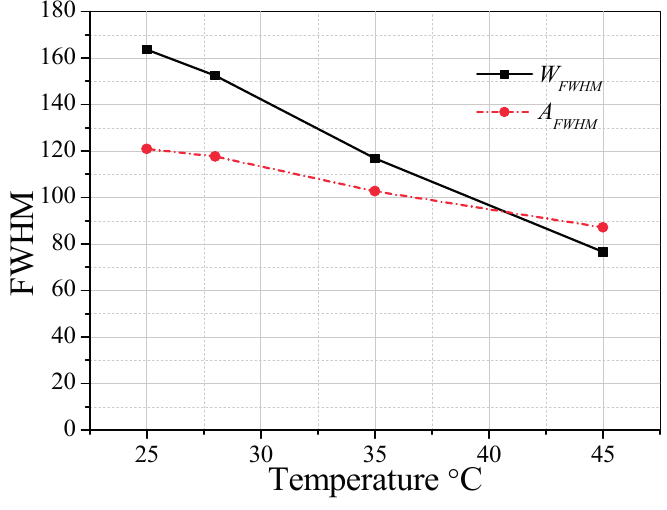
Figure 11. FWHM of water and acetone versus